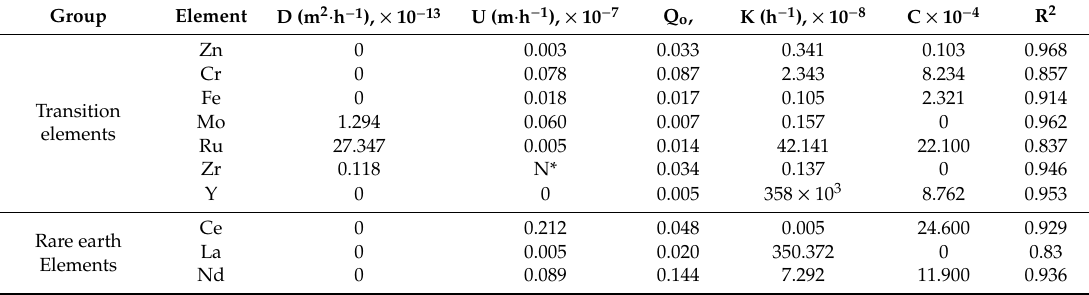
Table 16. Nonlinear curve fitting parameters of the cumulative leach fraction of transition and rare earth elements: MABS-Waste